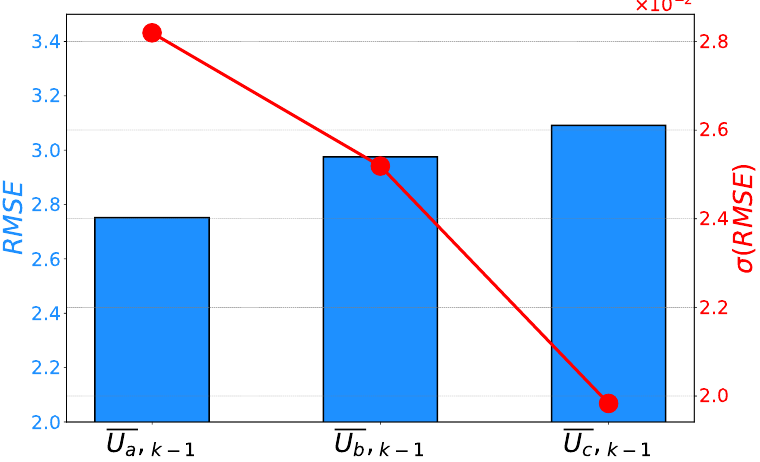
Figure 10. Mean RMSE scores and their standard deviations achieved on the prediction of phase